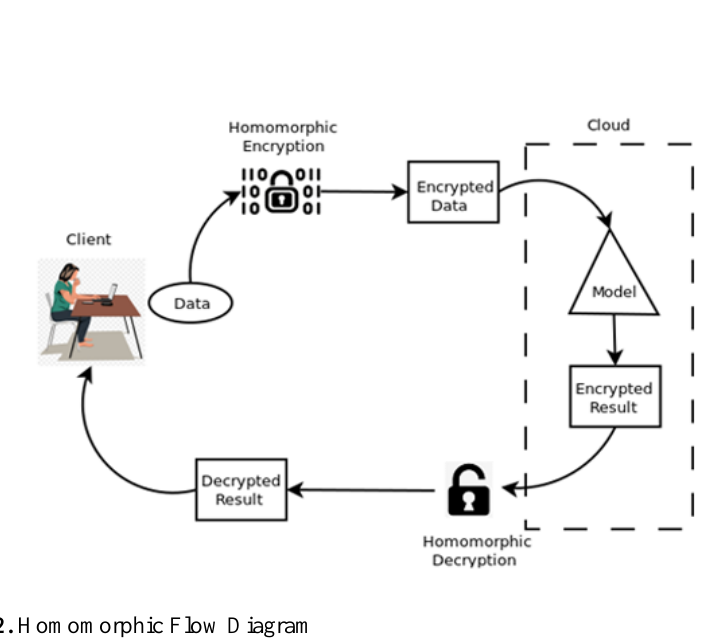
Figure 2. Homomorphic Flow